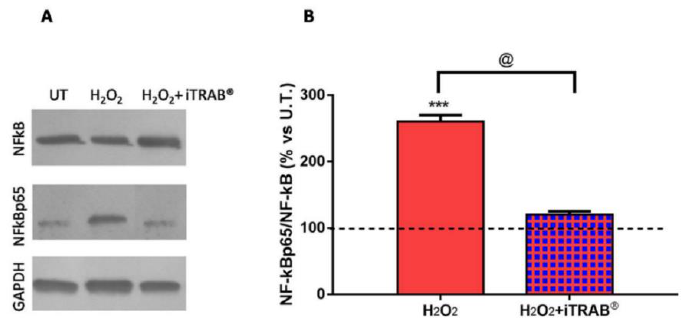
Figure 3. Western Blot Analysis. ( A ) The figures depicted are representative of at least three similar immunoblot analysis of NF-kB (p65), p-NF-kB (p65) protein levels in untreated 3Dhuman trabecular meshwork cells (HTMCs) and treated 3D HTMCs (H 2 O 2 /H 2 O 2 + iTRAB ® ). GAPDH was used as an internal control for equal protein loading on the gel. ( B ) NF-kBp65 activation was evaluated in 3D-HTMCs after the 3rd exposure of 500 µ M H 2 O 2 only and co-treatment with iTRAB ® and 500 µ M H 2 O 2 . The analysis was performed by immunoblotting and the bars represent the ratio of phosfoNF-kBp65 / NF-kBp65, and are expressed as % vs. untreated HTMC cultures. Data represent the mean ± standard deviation (SD) of 3 independent experiments. The black dotted line represents the protein level of the untreated HTMC. *** treated 3D HTMCs vs. untreated (U.T.); @H 2 O 2 -treated vs. H 2 O 2 + iTRAB-treated 3D HTMC. *** p < 0.001; @ p < 0.05 (Two-way ANOVA followed by Bonferroni’s